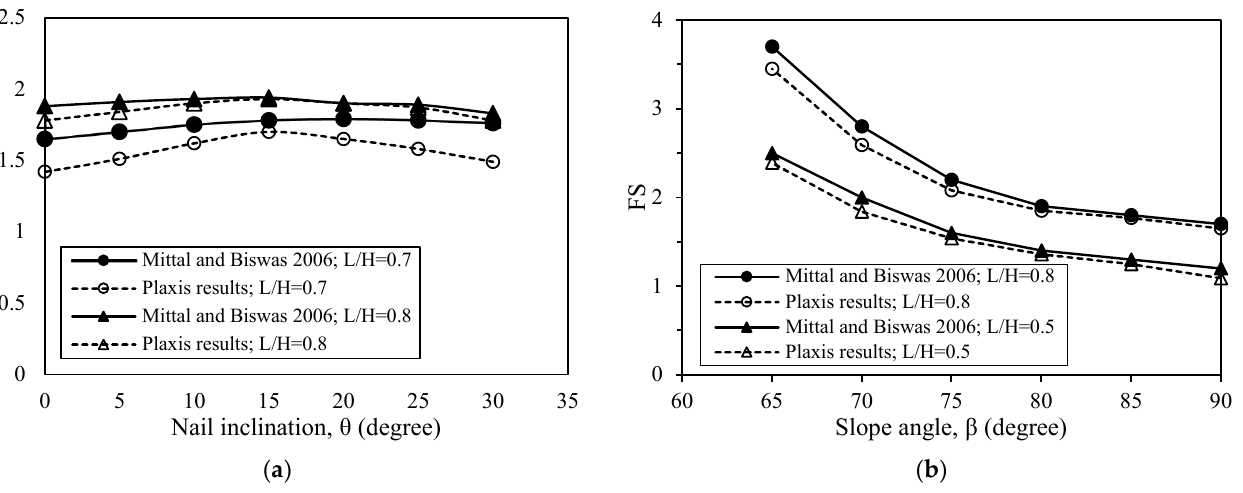
Figure 12. Comparison of FS between measured values and results from Mittal and Biswas [55]: ( a ) for different nail inclinations, ( b ) for different slope angles. Table 4. Material properties used by Rawat et al. [2].